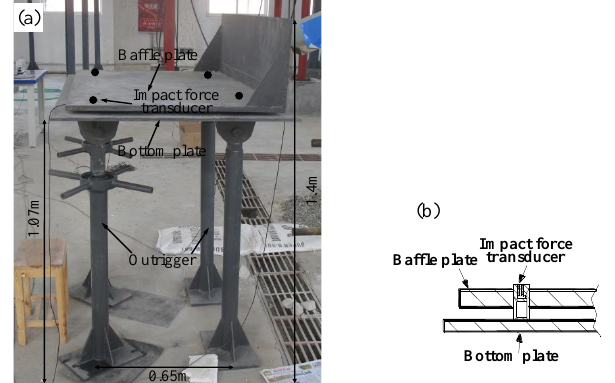
Figure 2. The protection device: (a) an overview and (b) configura- tion of force